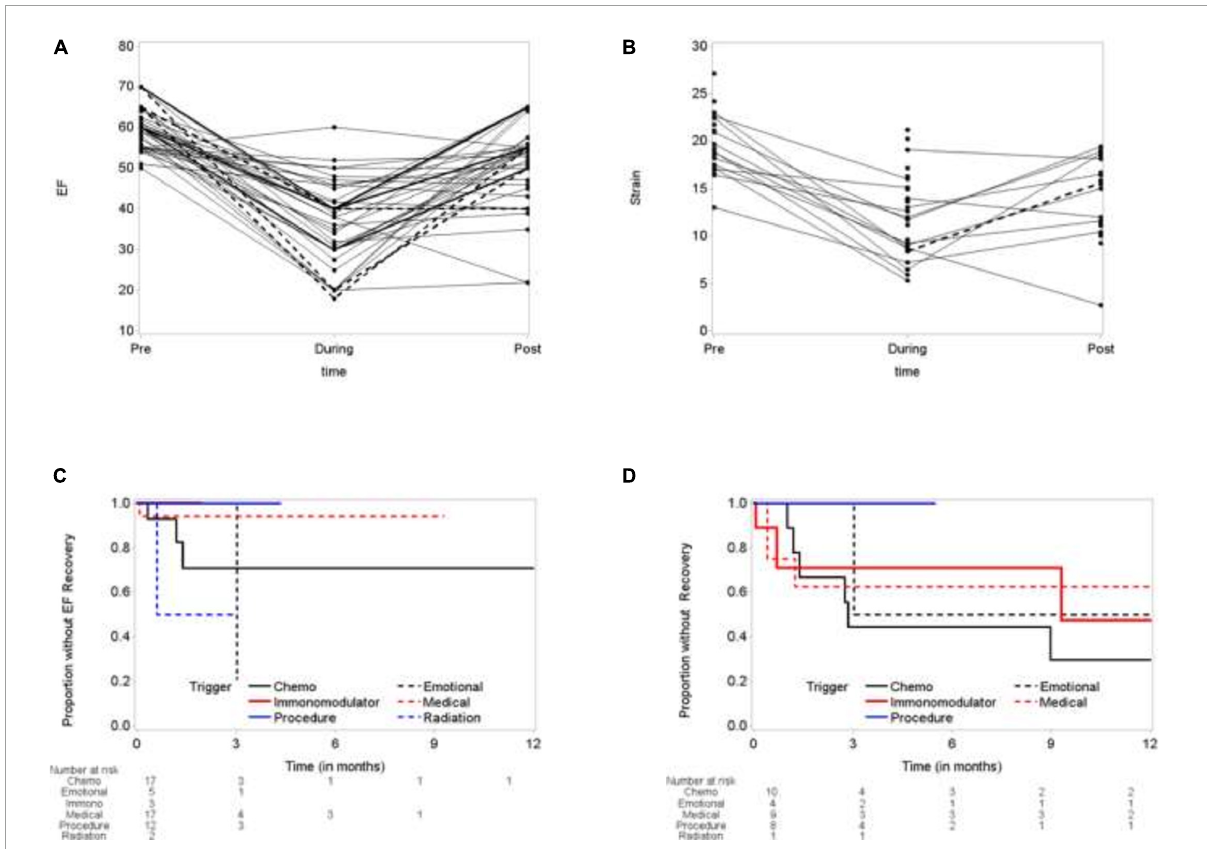
FIGURE3 Time to recovery of left ventricular ejection fraction (LVEF) and global longitudinal strain (GLS). (A) Election fraction (EF) comparing baseline, during TTS episode and following recovery. (B) Global longitudinal strain (GLS) at baseline, during TTS episode and following recovery. (C) Time to EF recovery. (D) Time to GLS Recovery.